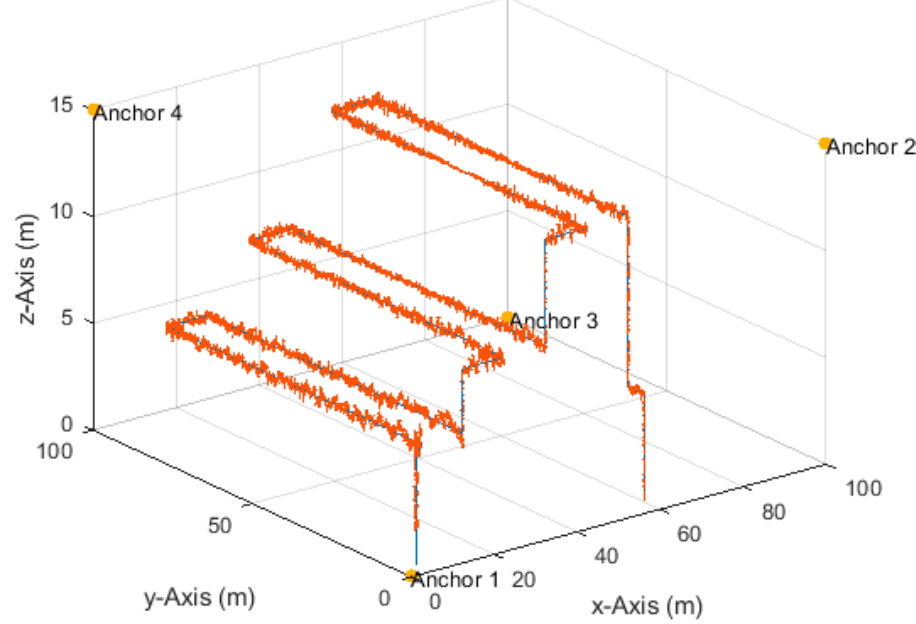
Figure 20. The particle filter position estimates (red) and ground truth (blue) of a single simulation run of the UAV-based inventory management scenario with a sampling range, R , of 0.3 m, and at an SNR of 50 dB and measurement update rate of 20 Hz.